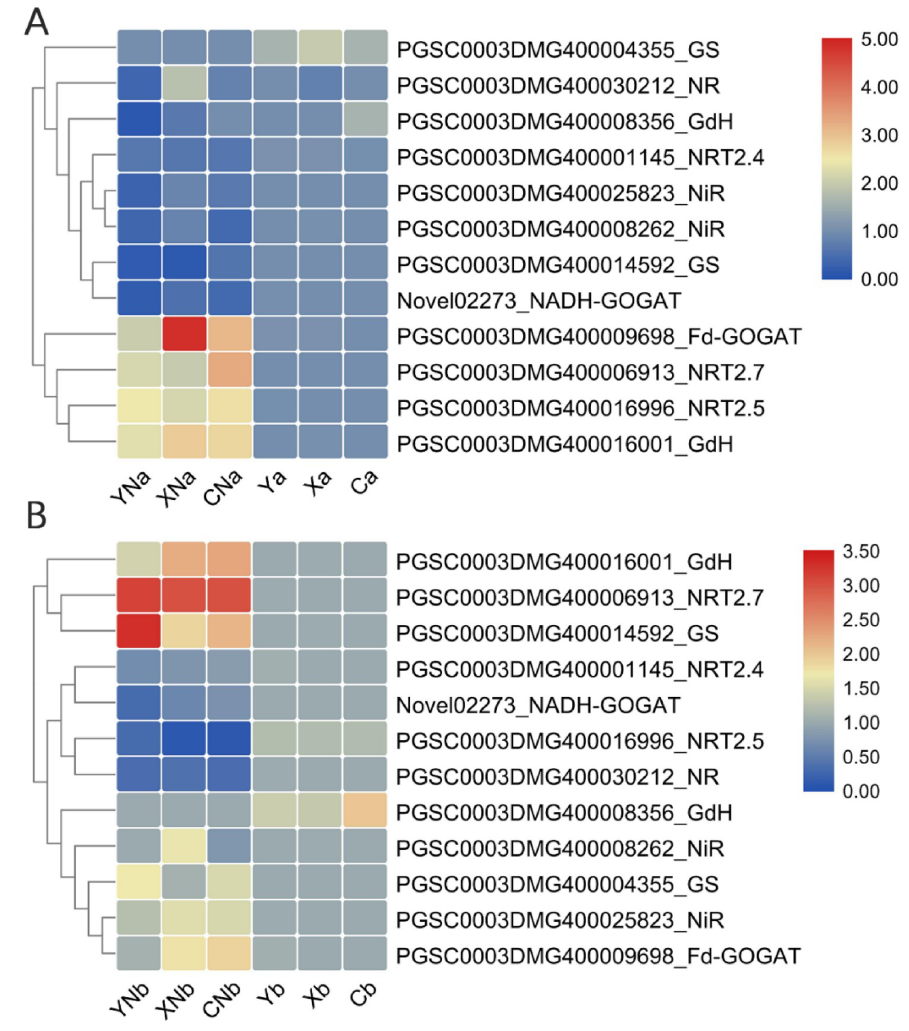
Fig 7. The expression profiles of the genes related to N metabolism in the leaf and root in response to N deficiency. A and B shows the expression profile of N metabolism-associated genes in the leaf and root tissue, respectively. The redder the color, the higher the amount of expression; each of the different color blocks on the left represents a class of transcript clusters with similar expression levels. A and b are short for leaf and root, respectively. Y, X and C indicate the cultivar of “Yanshu 4”, “Xiabodi” and “Chunshu 4”, respectively. N means treatment with N containing fertilizer (control). For example, YN and Y means “Yanshu 4” treated with N-containing and N-deficiency fertilizer,